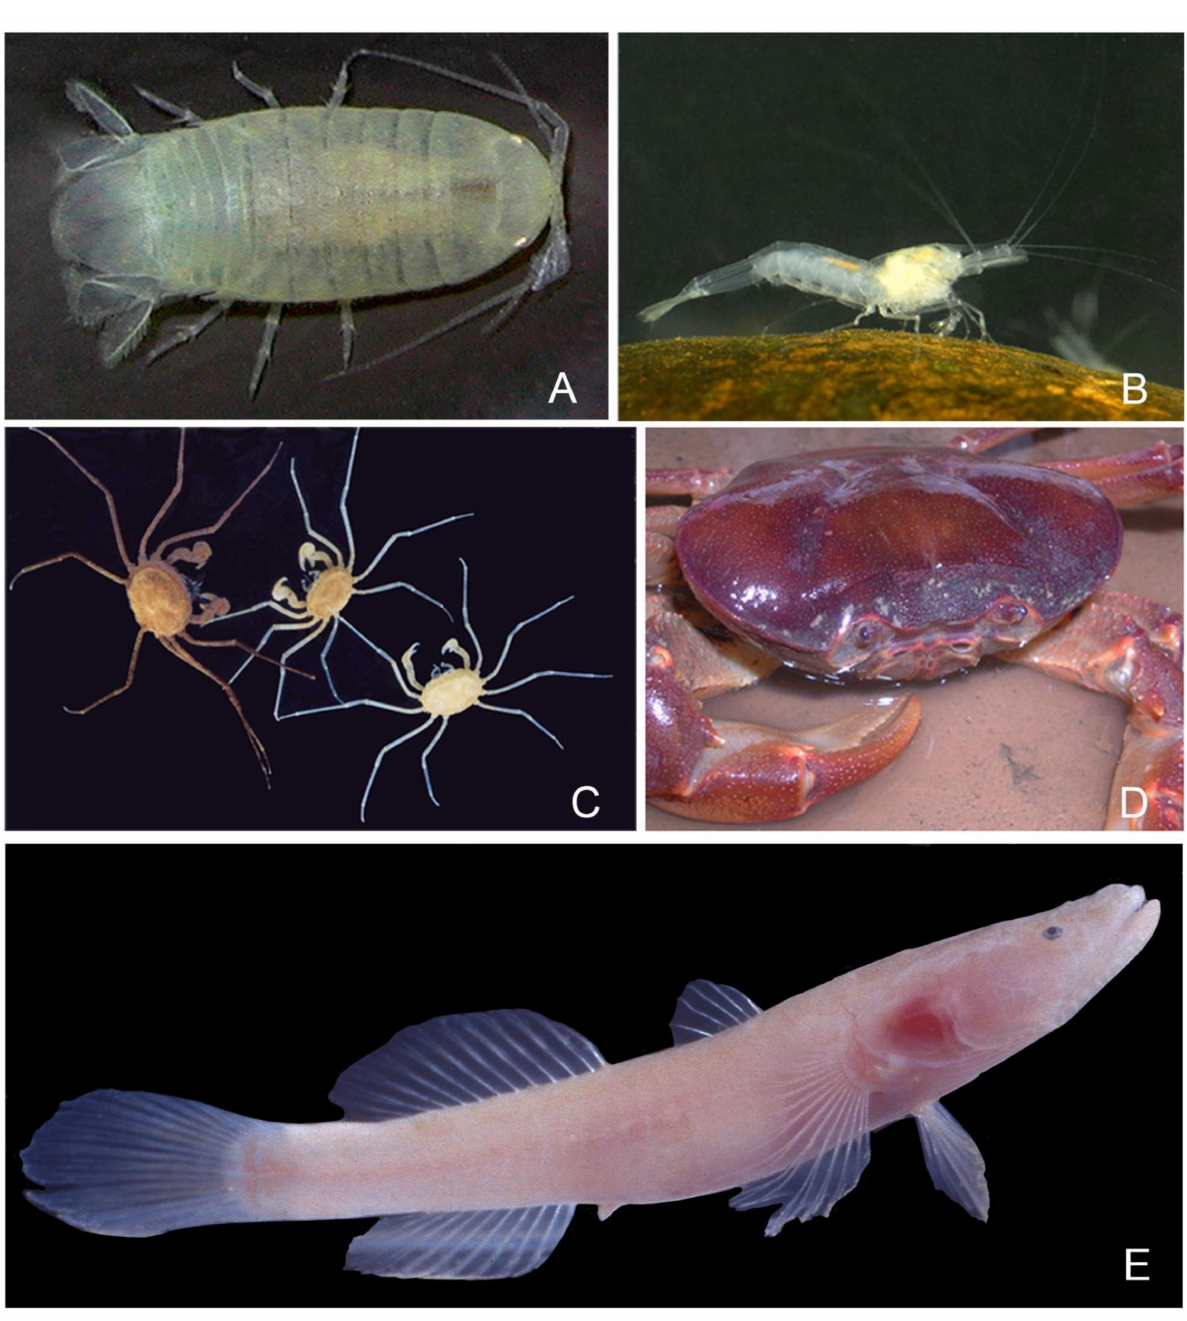
Figure 5. ( A ) Cirolana marosina from Leang Saripa; ( B ) Marosina longirostris from Leang Saripa; ( C ) Cancrocaeca xenomorpha from Lubang Batu Neraka; ( D ) Parathelphusa sorella from Leang Saripa; ( E ) Bostrychus microphthalmus from Gua Tanette. Reproduced with permission from Louis Deharveng ( A , D ); Jean-Yves Rasplus ( B ); Didier Rigal ( C , E